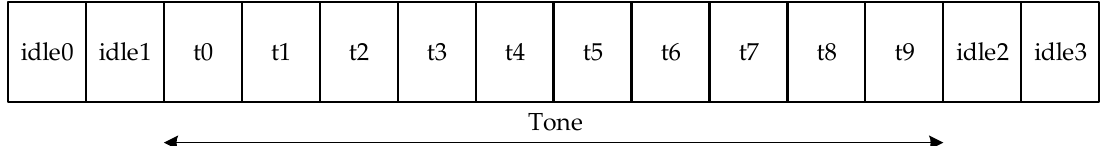
Figure 11. Diagram of time framing technique for narrowband sounding.